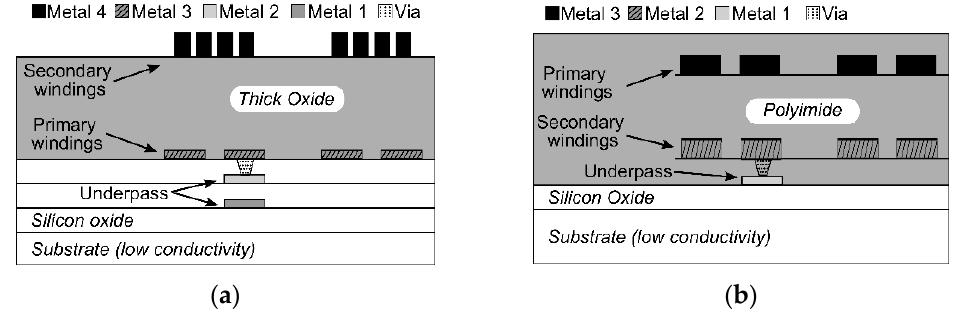
Figure 6. Isolation technology comparison: ( a ) thick-oxide technology; ( b ) polyimide technology.